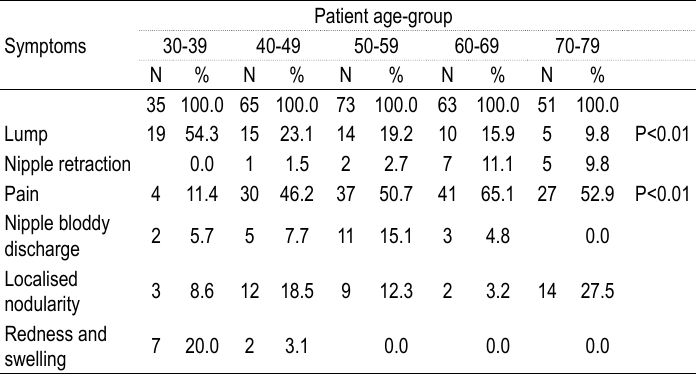
Table 3. benign breast symptoms according to age